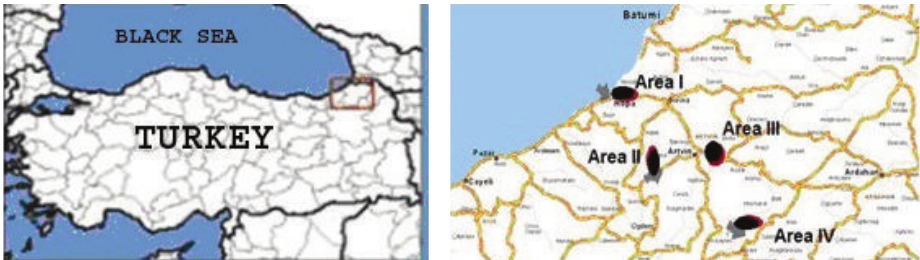
Figure 1: Four different study areas where utility poles were inspected in Artvin vicinity.